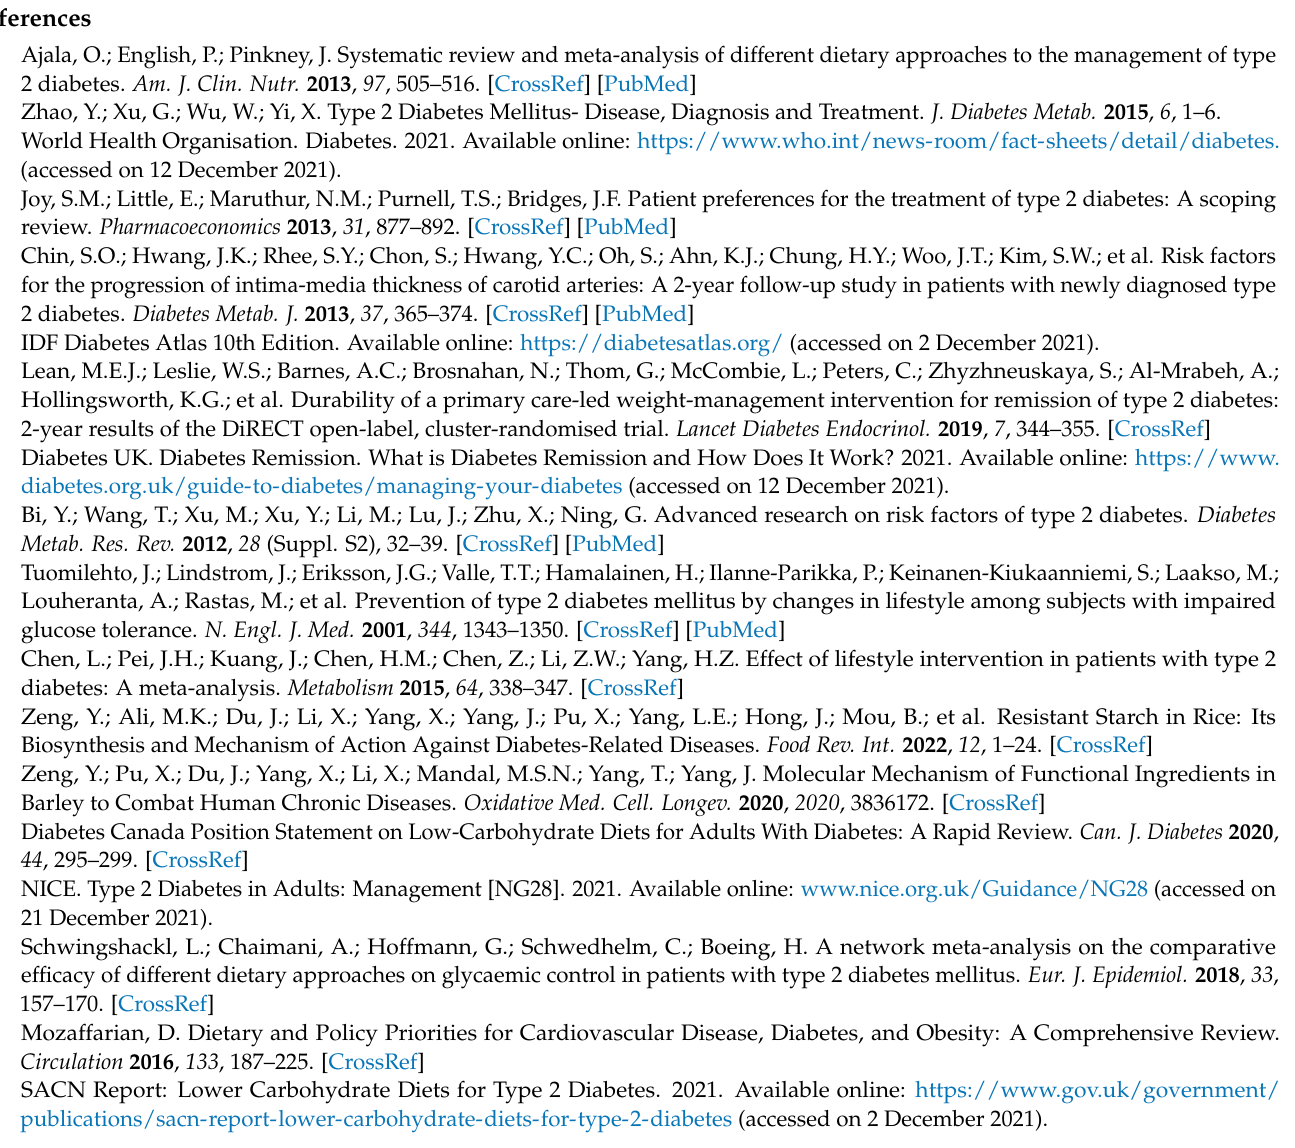
carbohydrate versus low fat diet and microalbumin. Figure S21. Low carbohydrate versus low fat diet and urea. Figure S22. Low carbohydrate versus low fat diet and urinary albumin. Figure S23. Low carbohydrate versus low fat diet and uric acid. Figure S24. Low carbohydrate versus low fat diet and medication effect score. Figure S25. Low carbohydrate versus low fat diet and risk of adverse